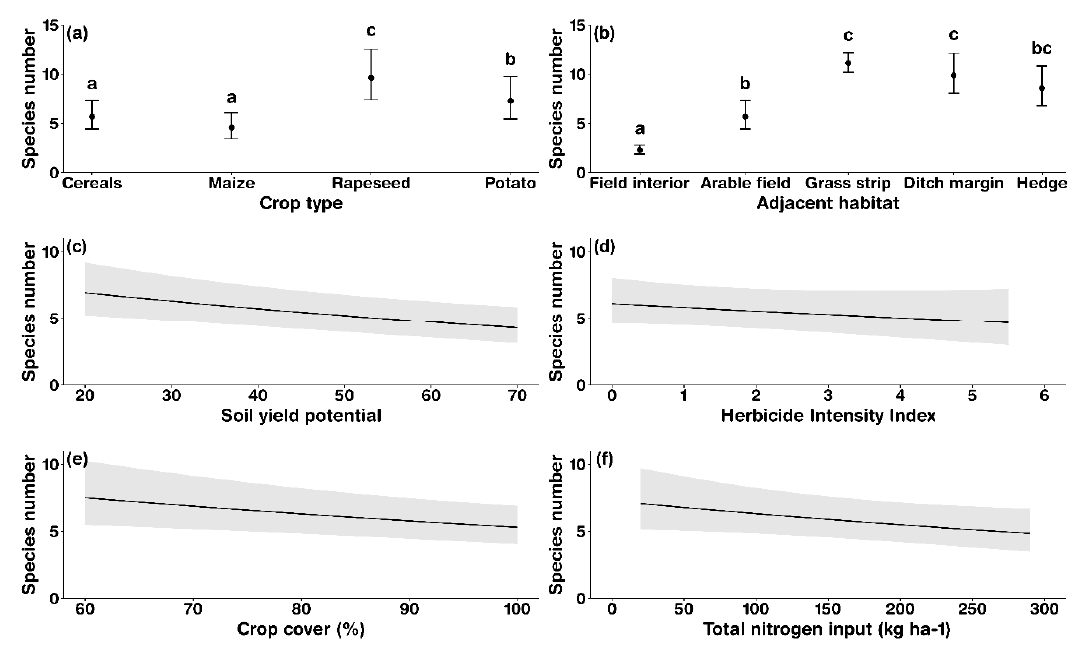
Figure 4. Number of herbaceous plant species (without woody plant seedlings and crops) at the field level for di ff erent crop types (all four cereals pooled; field edge and interior pooled) ( a ), or for plots with di ff erent adjacent habitats: field edge plots adjacent to ditch margins, grass strips, hedges and arable fields or field interior plots, i.e., no adjacent habitat, ( b ), number of plant species (field edge and interior plots pooled) in relation to soil yield potential ( Ackerwertzahl ) ( c ), Herbicide Intensity Index ( d ), crop cover ( e ) or total nitrogen fertilizer added ( f ) according to the generalized mixed e ff ects model ( n = 255 plots on 14 farms, 15 of 270 plots were excluded due to missing values of management data). Given are predicted means and 95% confidence intervals in ( a , b ); predicted values (black line) and 95% confidence intervals (grey, c – f ). Significant di ff erences between crop types and plots bordering di ff erent adjacent habitats are highlighted by small letters (multiple comparisons according to post-hoc Tukey tests, α ≤ 0.05). See Table S3 for details about the statistical analyses. Note that statistical results related to the comparison of maize, potato and adjacent hedge with the respective reference level of the model (all cereals pooled or adjacent arable field) were not clearly supported by